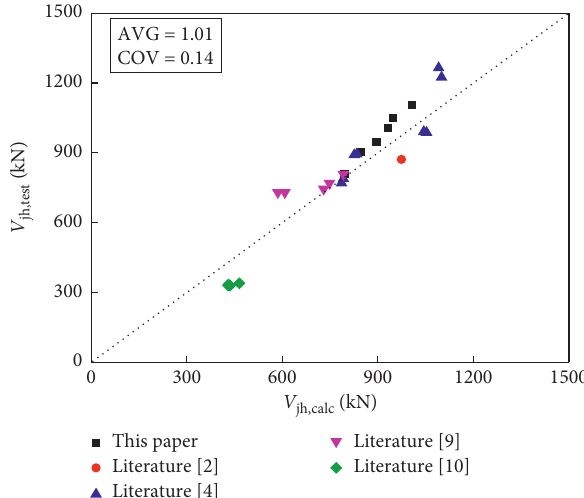
Figure 11: Correlation of experimental and predicted wall shear strengths.